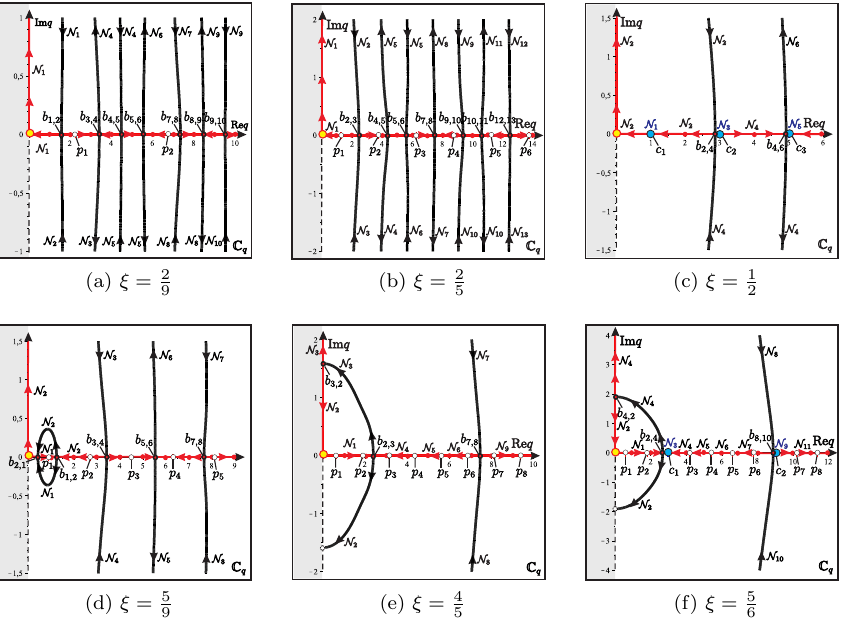
Figure 6. (a)–(f) Spectrum Domain (Spectrum Curves) for various parameter ξ values. – Constant Eigenvalue Point. Arrows show the direction in which γ is increasing. So, EP from E ξ ( γ ) is moving along this curve. We call this curve the Spectrum Curve . Zero Point is not CP (see Lemma 1) and in the neighborhood of Zero Point the Spectrum Curve belongs to R + (see Figure 5a). When γ → ±∞ the Spectrum Curve q N ( γ ) is approaching to ∂ D ξ = P ξ ∪ {∞} (see Figure 6). PP is not CP, too, and all Poles are of the first order. So, in the neighborhood of PP, Spectrum Curves belong to R + (see Figure 5b), and γ values in the limit correspond to q −∞ and + ∞ . For other problems the structure of Spectrum Curves may be more complex (see Figure 5f for a pole of the second order